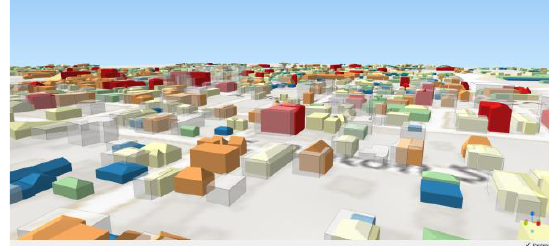
Figure 17. Panoramic view of the LOD2 3D City Model.